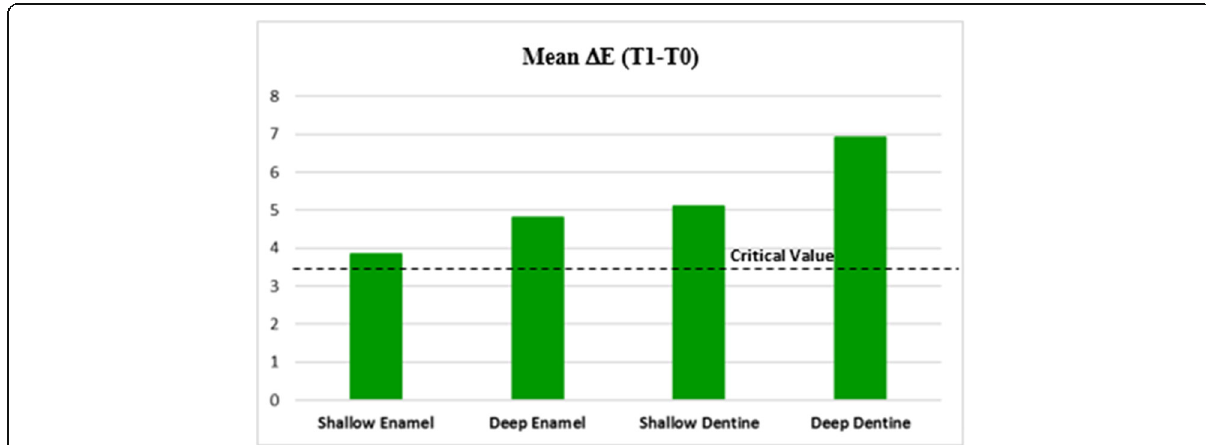
Fig. 5 Bar graph showing the extent of the mean Δ E after WSL formation (T1-T0) in shallow enamel, deep enamel, shallow dentine, and deep dentine